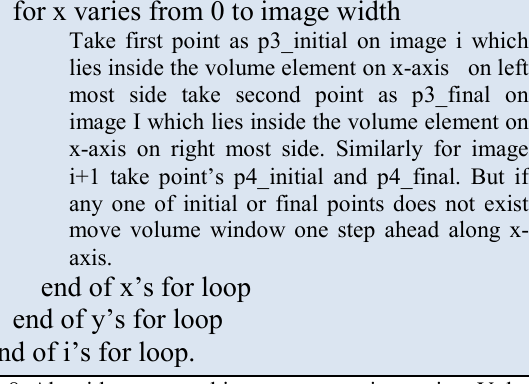
Fig. 8 Algorithm to combine contour points using Volume Element to build 3D